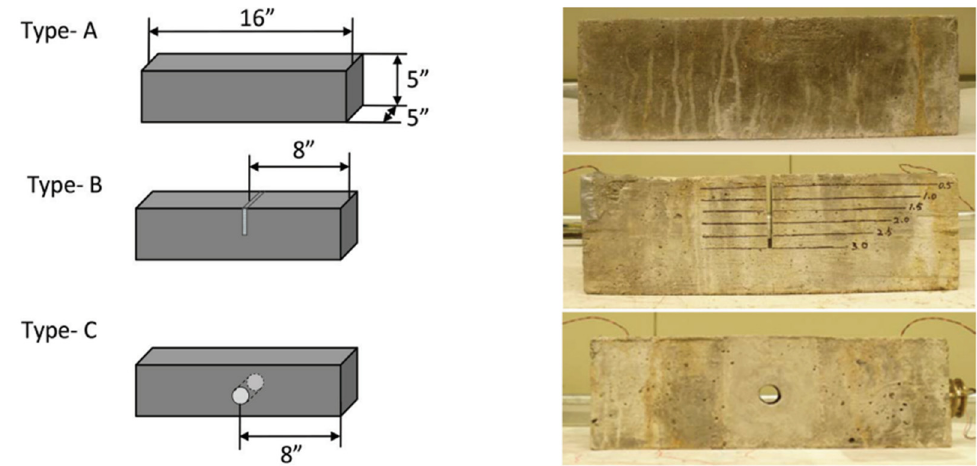
Figure 24. Experimental specimen with crack and hole [48].